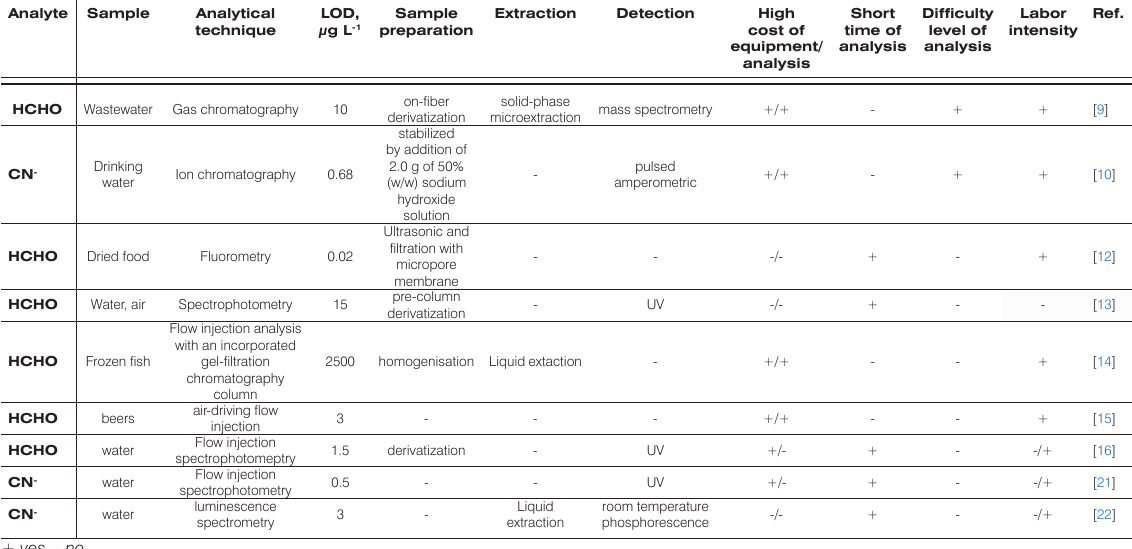
Table 1. Advantages and disadvantages of various analytical techniques used for determining HCHO and CN - in water and other samples. Analyte